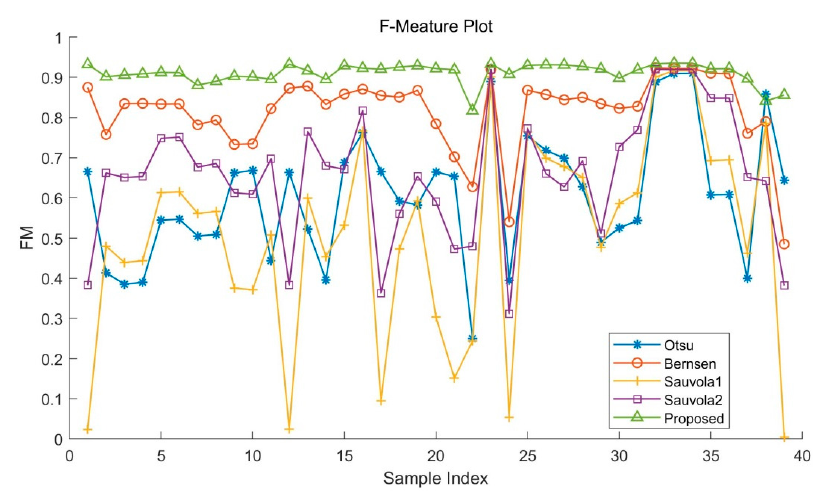
Figure 16. F-Measure of the dataset with different algorithms.